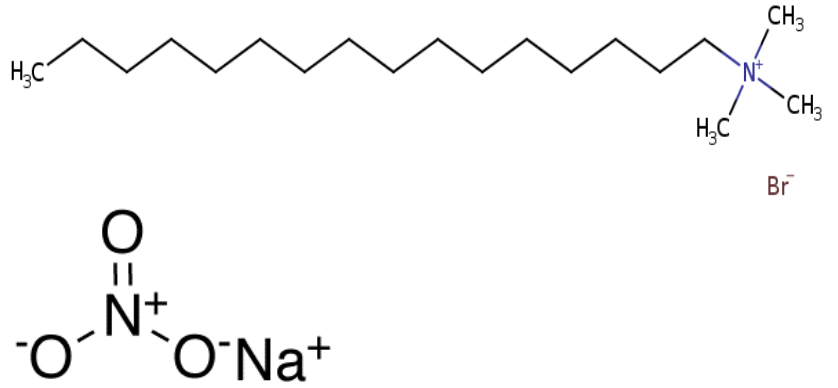
in Figure 1). The nanofluid of ZnO dispersion nanoparticles (<100 nm particle size TEM), 20 wt% in H 2 O was obtained from sigma Aldrich.